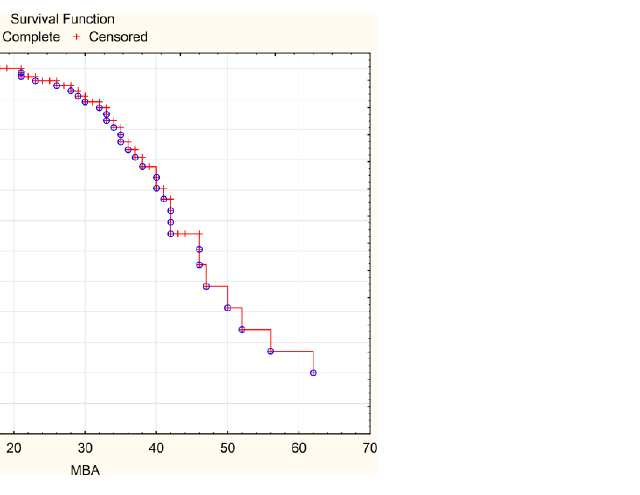
Fig 5. Survival Function for MBA. MBA — meniscus-bone angle.